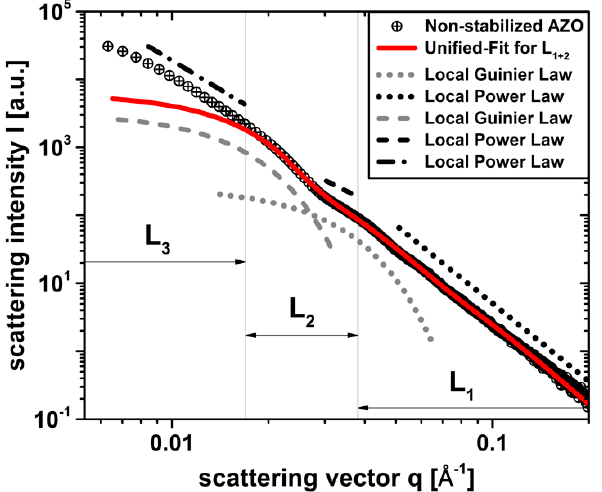
Figure 1. SAXS curveofanon-stabilized AZO dispersioninethanol(blackdots)includingthelocalGuinier- Figure 1. (cid:1845)(cid:1827)(cid:1850)(cid:1845) curve of a non-stabilized (cid:1827)(cid:1852)(cid:1841) dispersion in ethanol (black dots) including the local and Power-laws of three particulate population levels L 1 (dotted), L 2 (dashed), and L 3 (dotted / dashed). Guinier- and Power-laws of three particulate population levels (cid:1838) (cid:2869) (dotted), (cid:1838) (cid:2870) (dashed), and (cid:1838) (cid:2871) L 1 and L 2 were approximated using the Unified-Fit model according to Beaucage (solid (dotted/dashed). (cid:1838) (cid:2869) and (cid:1838) (cid:2870) were approximated using the Unified-Fit model according to Beaucage (solid line).